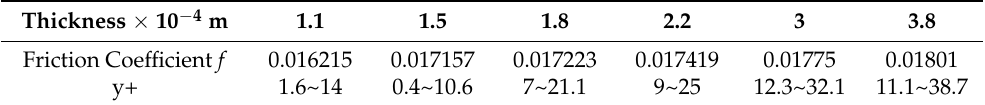
Table 3. Boundary layer mesh